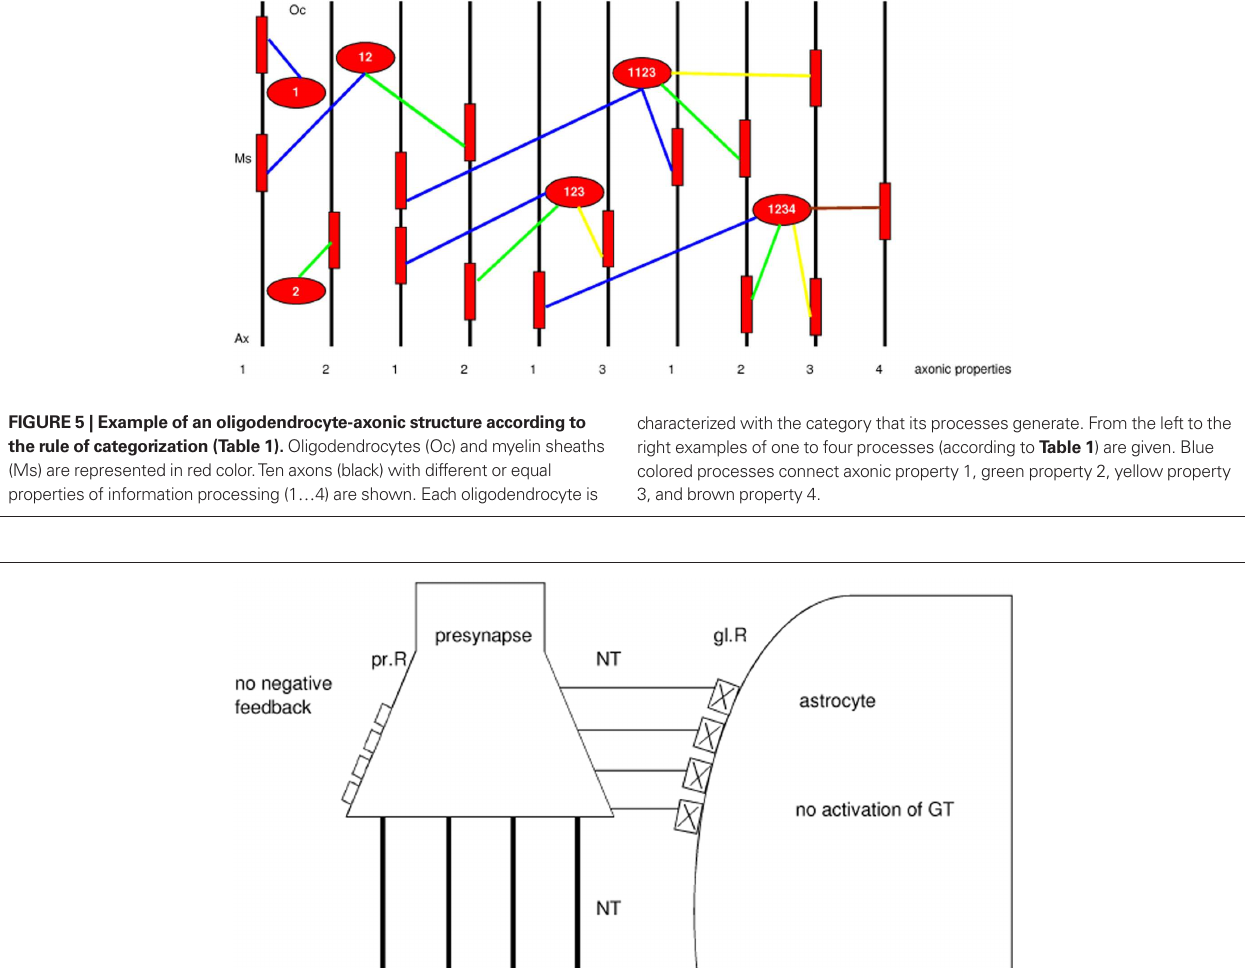
Figure 6 | Model of an unbalanced tripartite synapse that may cause schizophrenia. Non-functional glial receptors (glR), depicted by crosses, cannot be occupied by neurotransmitters (NT). Since the activation and production of